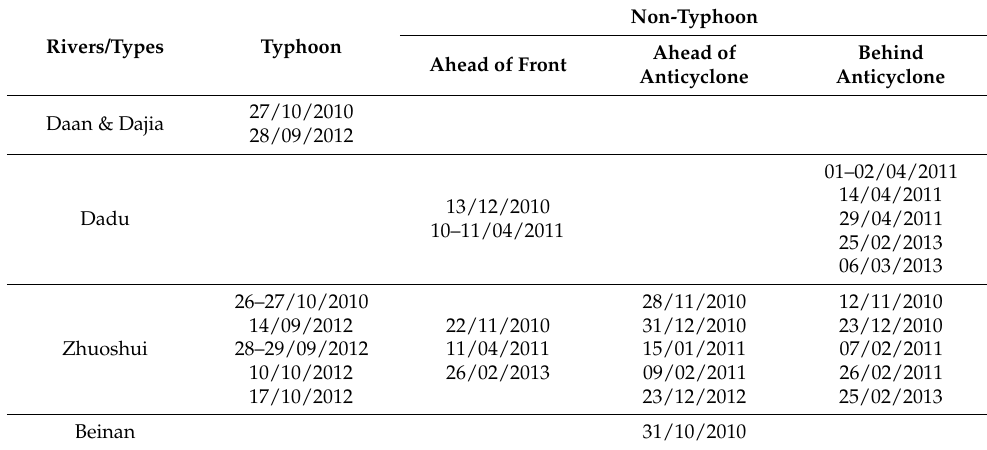
Table 1. Riverbed events (day/month/year) with daily averaged PM 10 greater than 125 µ g m − 3 for each of the major rivers are classified into different